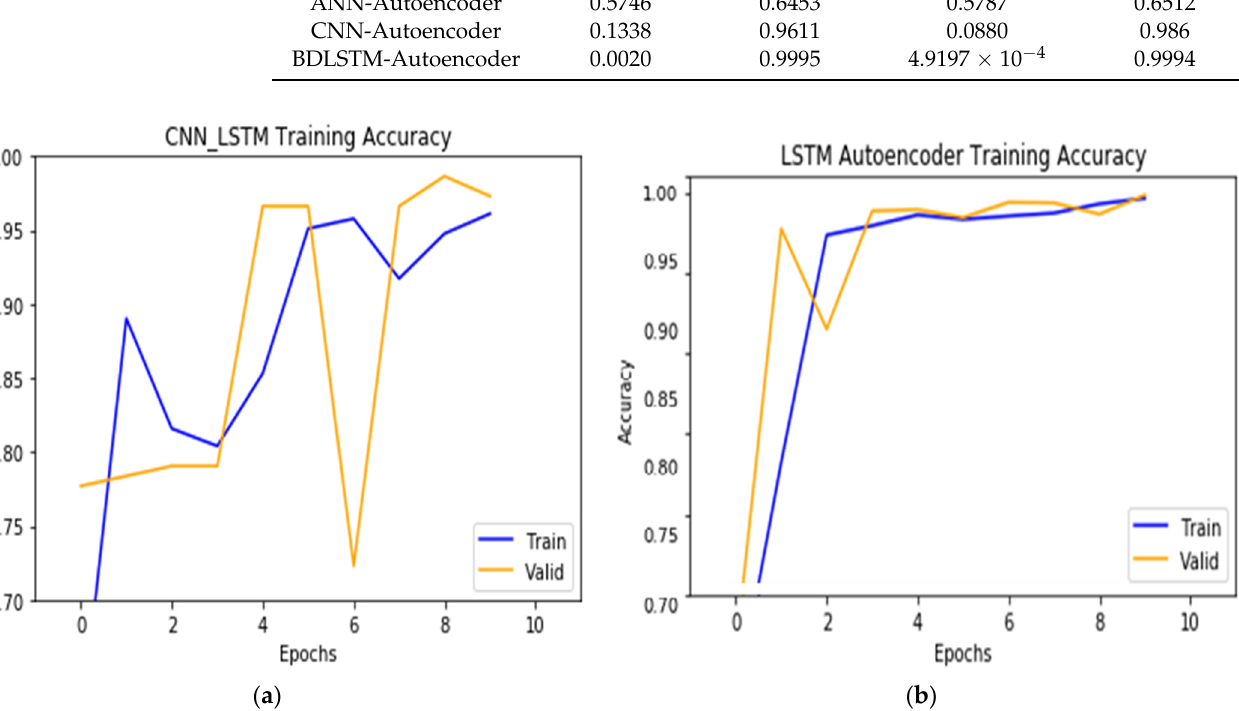
Figure 6. Accuracy results for ( a ) the CNN-autoencoder model, and ( b ) the BDLSTM-autoencoder model.